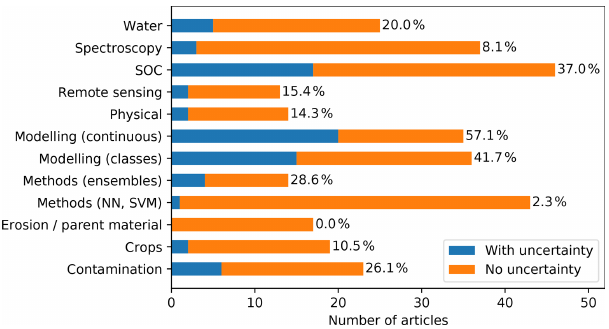
Figure 12. Number of articles per topic that report or mention “un- certainty”. Percentage represents the proportion of total articles per